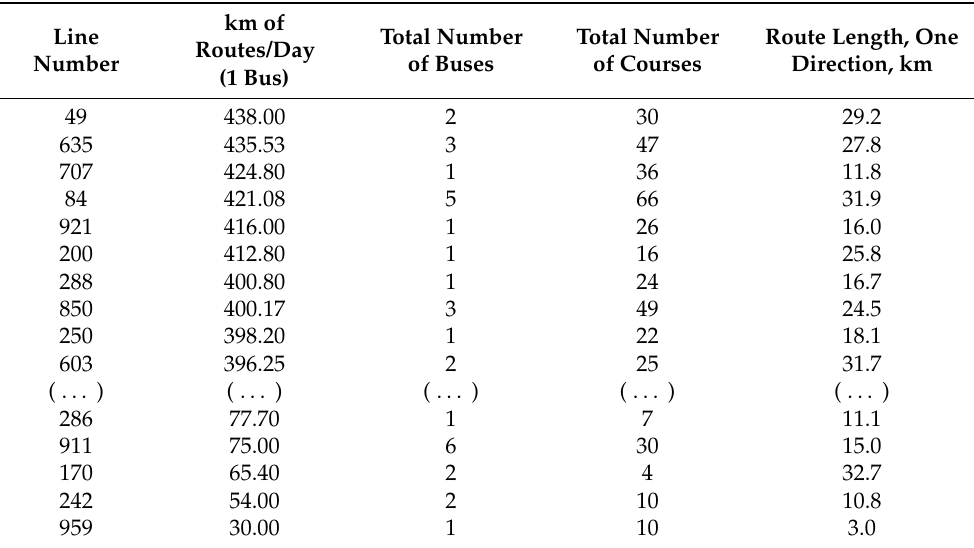
Table 1. A part of the table with selected parameters of the city busline, ordered in descending order by the number of kilometers traveled by one bus from a given line per working